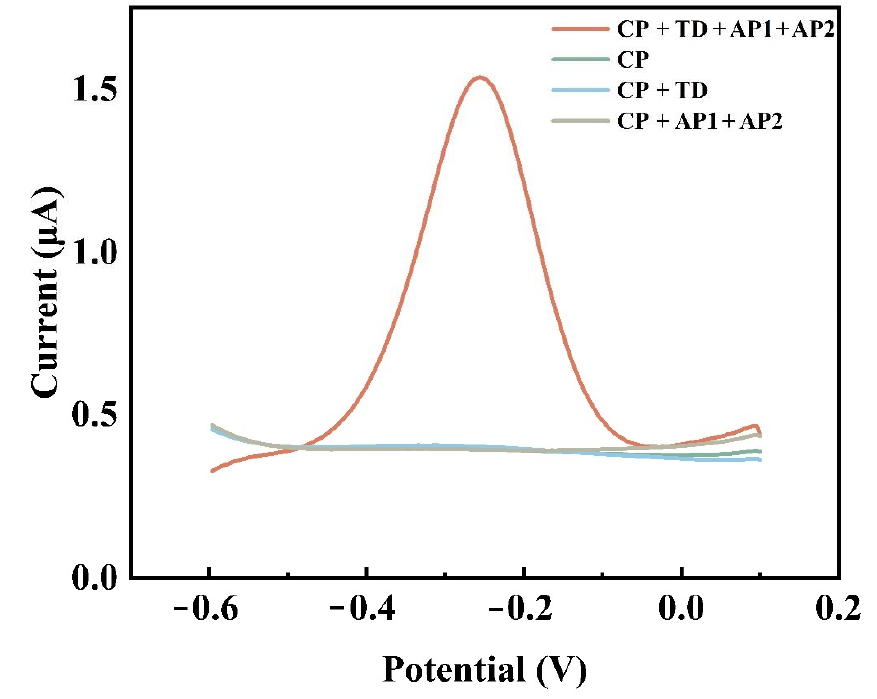
Figure 3. Comparison of DPV response values of the electrodes in the presence of different oligonu- cleotides. (CP: capture probe, TD: target DNA, AP1: auxiliary probe 1, AP2: auxiliary probe 2.) The concentration of each oligonucleotide was 1 µ